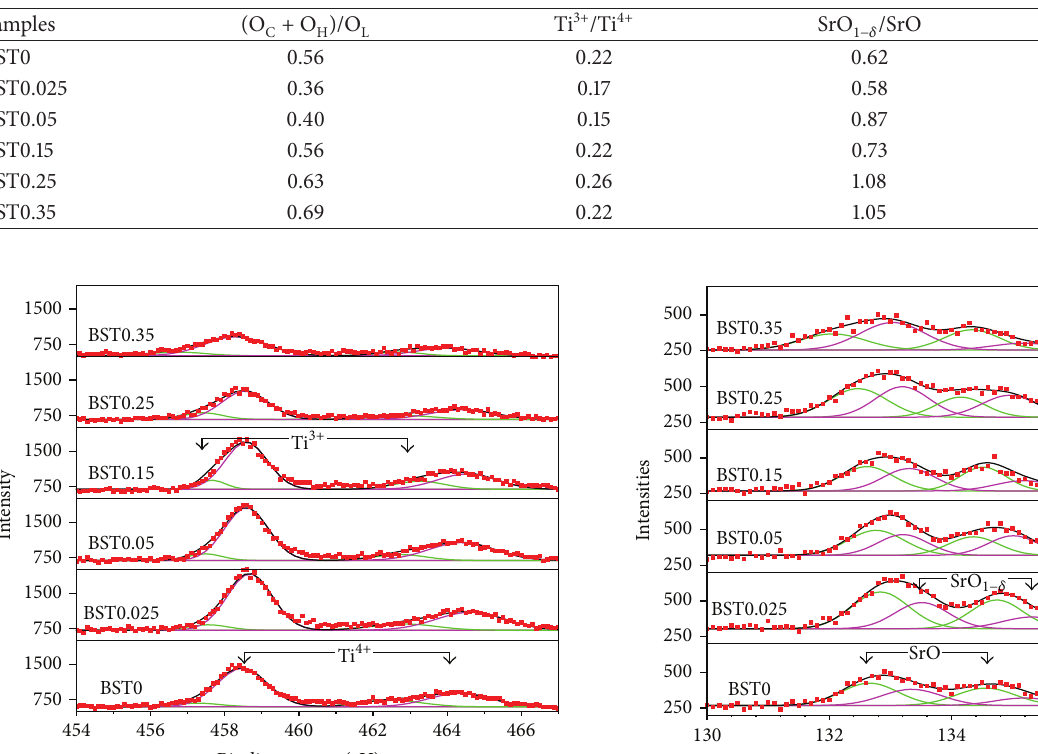
Table 2: The atomic ratio calculations of O 1s, Ti 2p, Sr 3d, and Ba 3d.